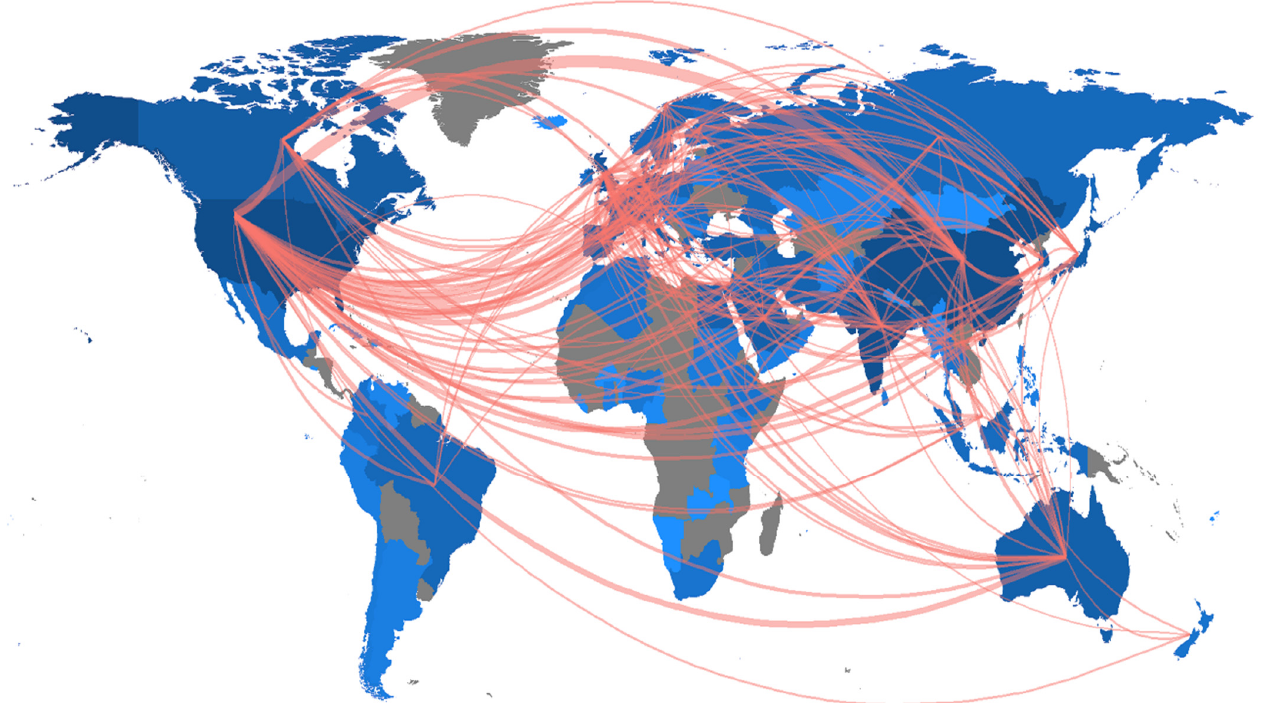
Figure 4. International co-collaboration map (generated with Biblioshiny).